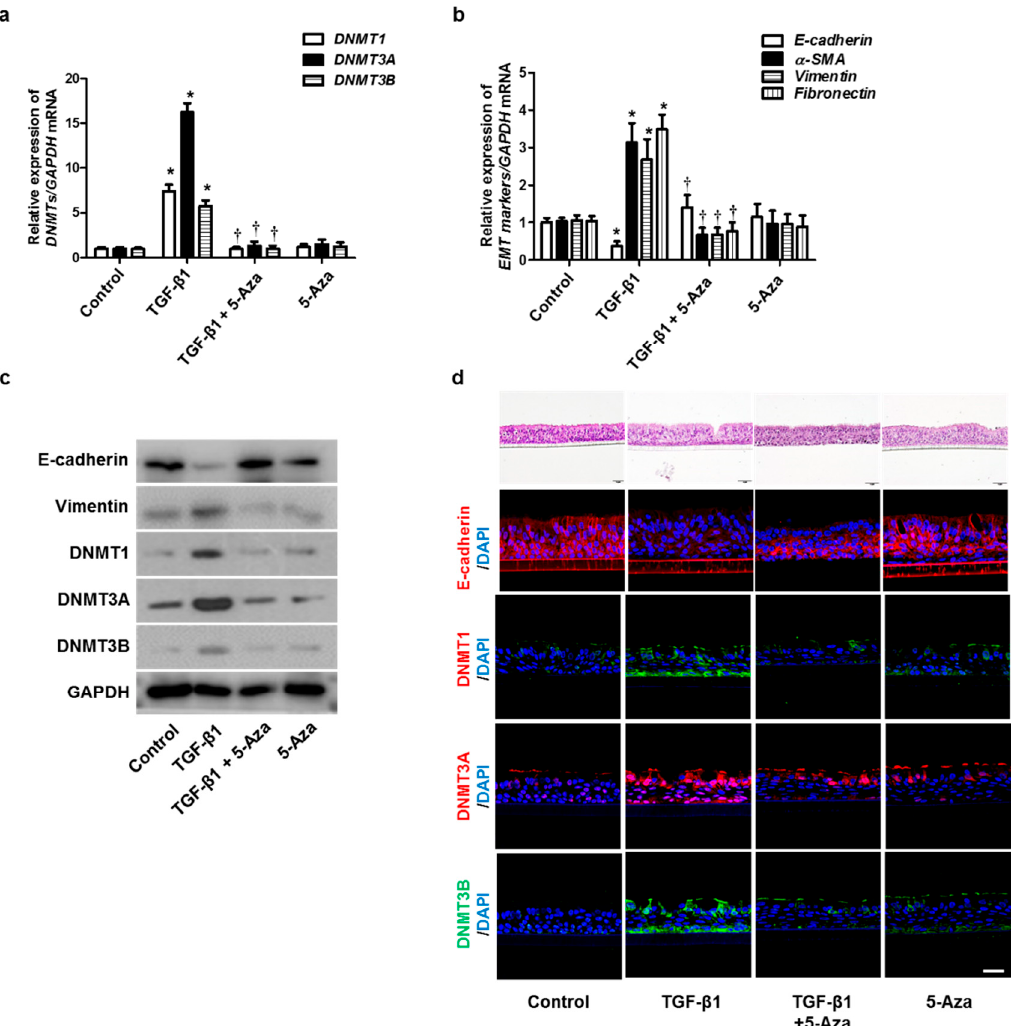
Figure 7. Effects of 5-Aza on EMT induced by TGF- β 1 in primary nasal epithelial cells and air–liquid interface culture. Human primary nasal epithelial cells were stimulated with TGF- β 1 (5 ng/mL) with or without the DNMT inhibitor (5-Aza, 10 µ M): ( a , b ) mRNA expression levels of DNMT1, DNMT3A, DNMT3B, and EMT-related markers were determined using RT–PCR; ( c ) protein expression levels of DNMT1, DNMT3A, DNMT3B, and EMT-related markers were measured using Western blotting; ( d ) effects of 5-Aza on E-cadherin, DNMT1A, DNMT3A, and DNMT3B expression in TGF- β 1-stimulated human primary nasal epithelial cells were determined using immunofluorescence. Values are expressed as the mean ± SEM of three independent samples using primary nasal epithelial cells isolated from three different CRS patients. * p < 0.05 vs. control; † p < 0.05 vs. TGF- β 1 alone.